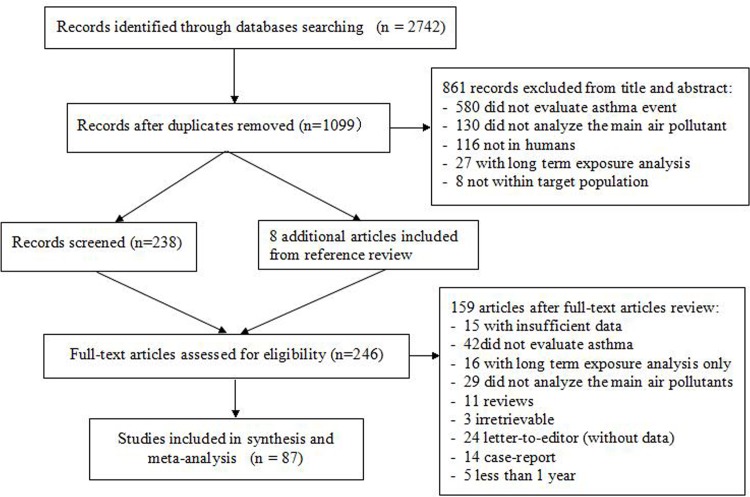
Study flow chart.